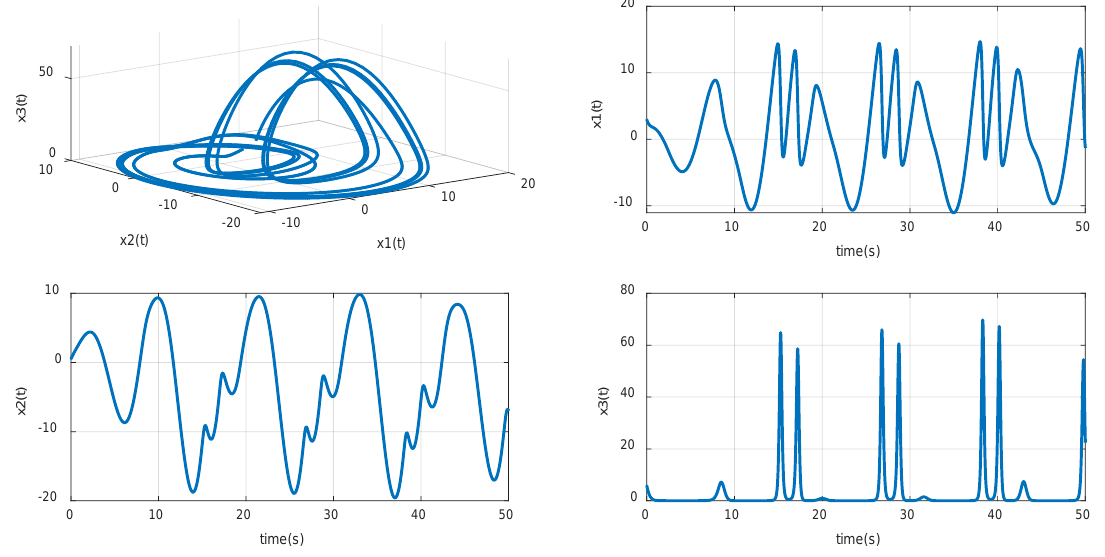
Figure 1. The chaotic behavior of system dynamics.